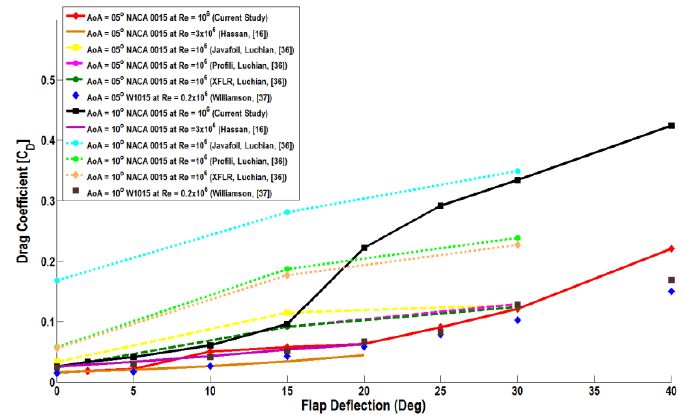
Figure 17. Comparison of the effect of flap deflection on drag coefficient values at AoA = 5° and AoA = 10° with Hassan’s [16] simulations, Luchian’ [36] results and Williamson’s [37] experiments. The effect of flap deflection on lift increment is presented next. A lift increment ∆ 𝐶 𝑙 is the amount of lift that is gained or lost due to a flap deflection measured from a reference configuration. The airfoil with zero flap deflection is taken as the reference case. The trend in these plots is compared with the experimental data of Williamson [37] for the W1015 symmetrical airfoil tested at Re = 4 × 10 5 at zero flap deflection and 10° flap deflection.